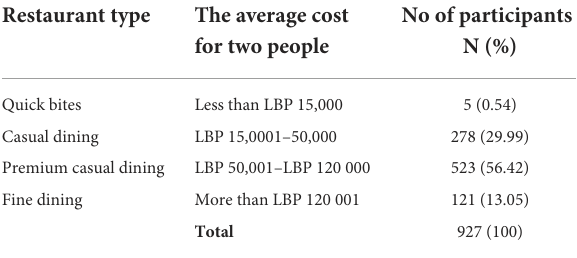
TABLE 1 Restaurants classification based on the average cost for two people.